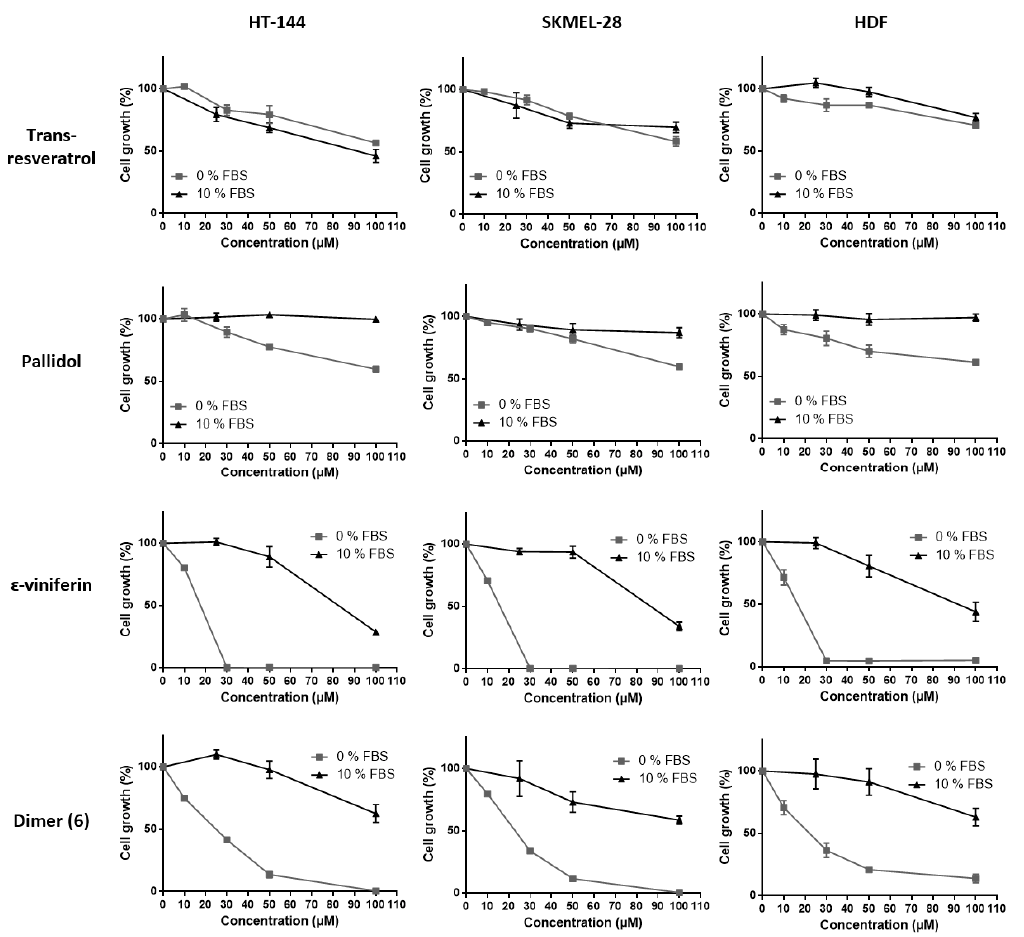
Figure 5. Cell viability inhibition of bio-produced stilbenes (resveratrol and the three dimers) with or without FBS. HT-144, SKMEL-28 and HDF cells were treated with various concentrations (10–100 μ M) of bio-produced stilbenes for 24 h with FBS (10% FBS) or not (0% FBS). Cell viability was determined by the MTT assay. The final volume of ethanol was 0.01% and 0.1% for 10 and 100 μ M concentrations, respectively. Data are expressed as the means ± SD of 3 independent experiments. Each experiment was performed in triplicate.